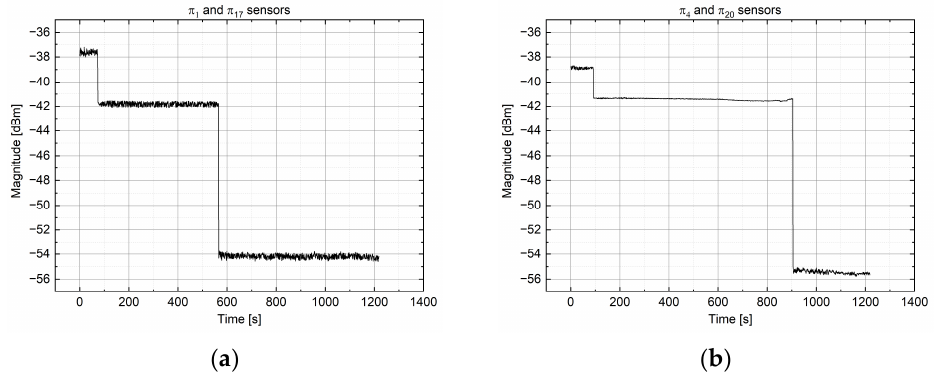
Figure 13. Resin presence on the sensor P1 and P17 ( a ) and P4 and P20 ( b ).